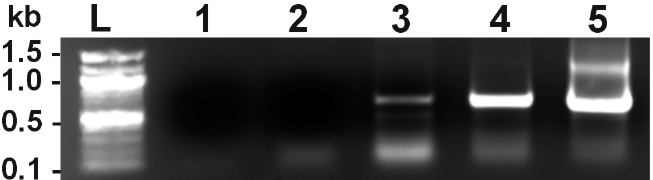
Figure 1. Expression of Rhobtb3 in a mouse megakaryocyte cell line. RT-PCR was performed on RNA extracted from the mouse megakaryocyte cell line MKD1 (lane 3) or mouse adult heart (lane 4).